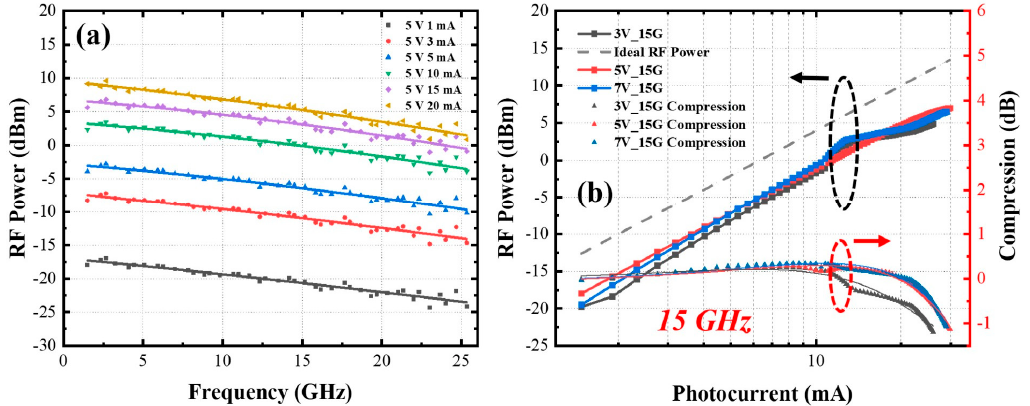
Figure 14. ( a ) Frequency responses of PD array at different photocurrents. ( b ) RF output power and compression of the PD array at 15 GHz.